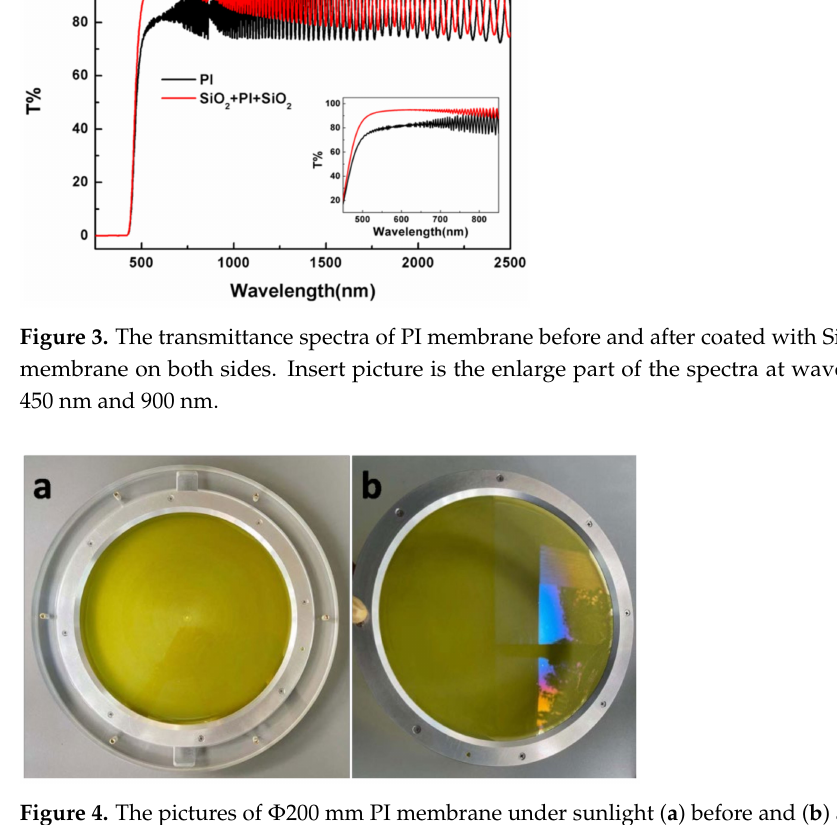
Figure 4. The pictures of Φ 200 mm PI membrane under sunlight ( a ) before and ( b ) after coated with SiO 2 antireflective membrane on both sides.